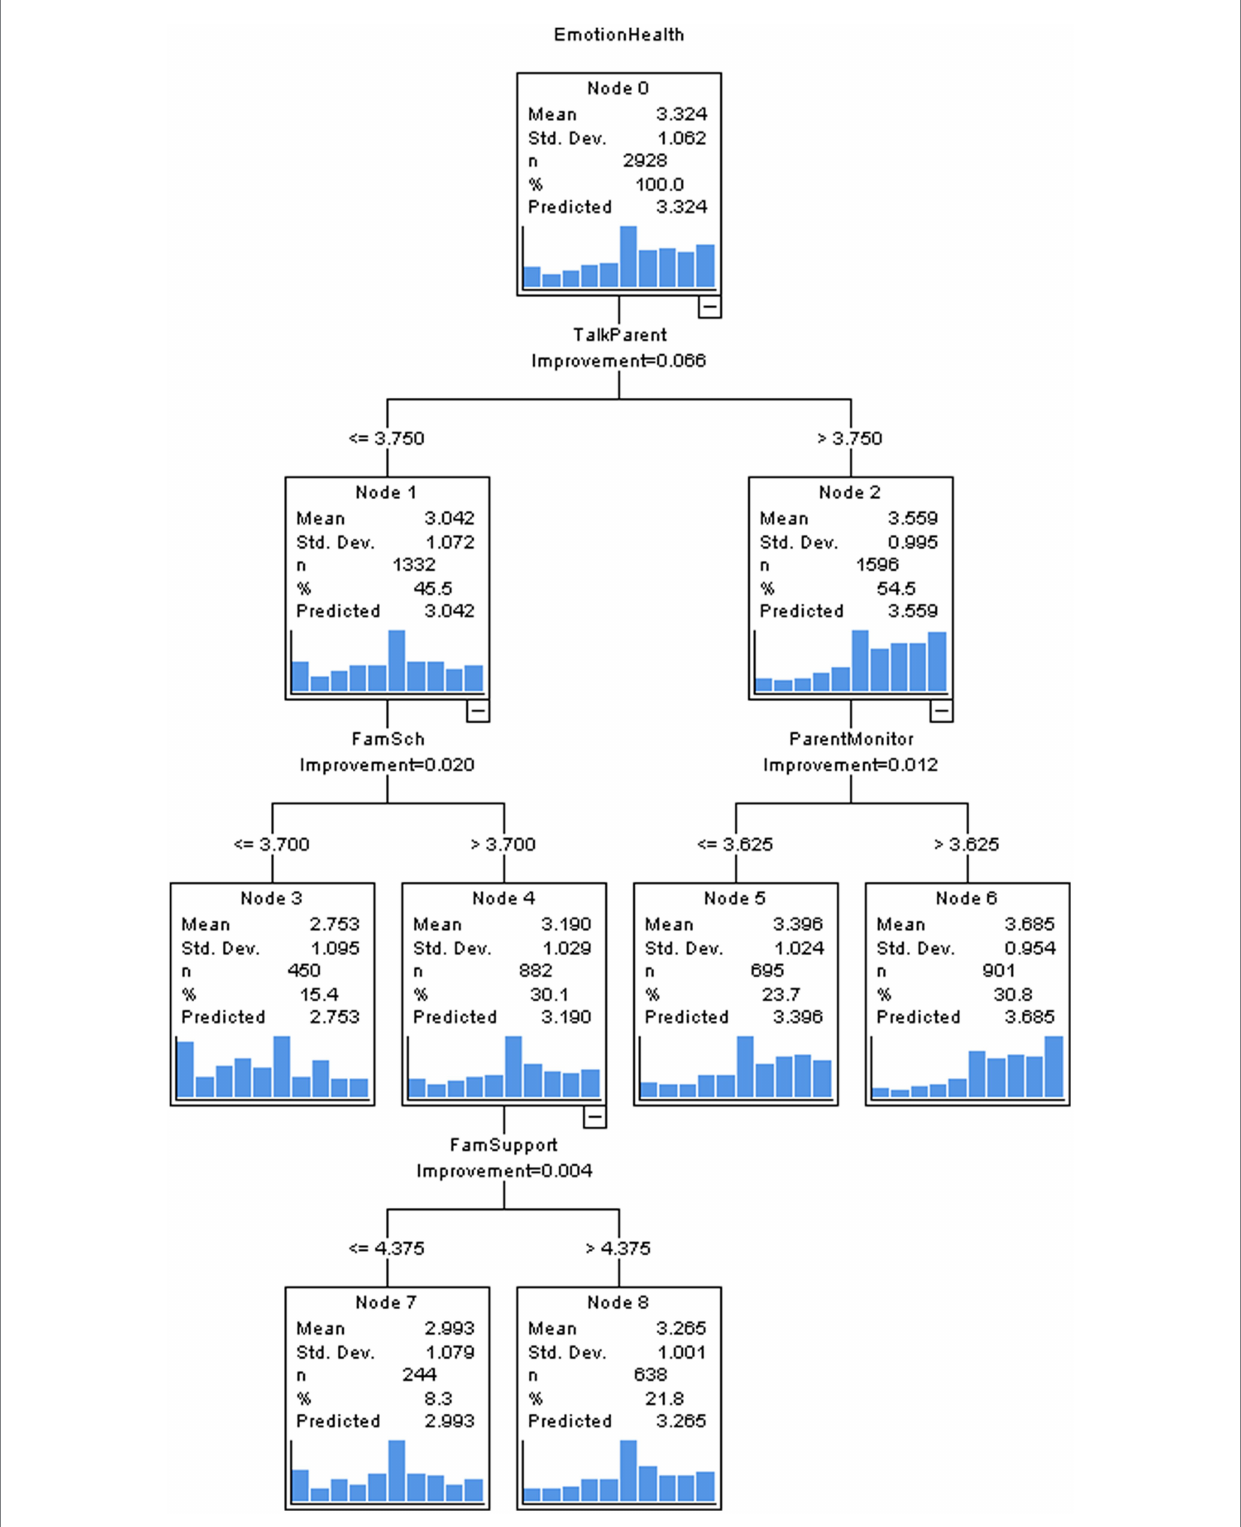
FIGURE 2 The CRT model to predict adolescents with chronic condition(s) by family-related